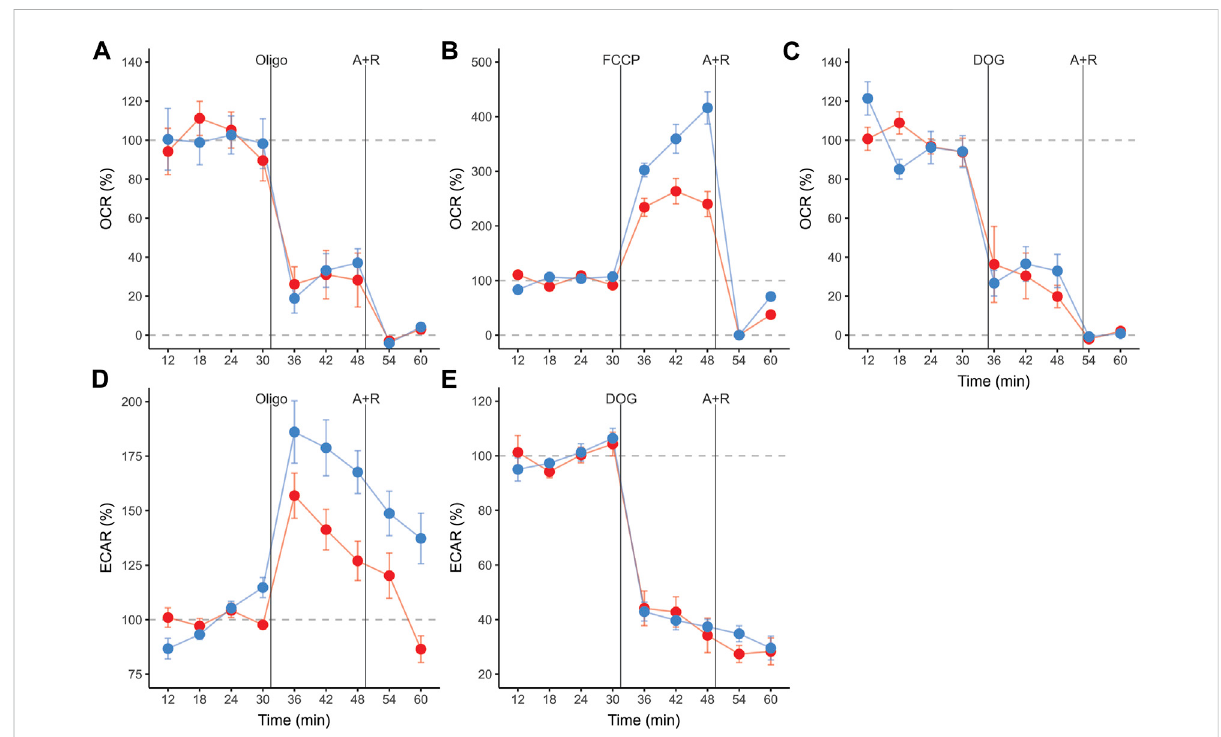
FIGURE 3 Real-time measurements of oxygen consumption rate (OCR) (A,B,C) , and extracellular acidi fi cation rate (ECAR) (D,E) in mouse sperm before and after treatment with metabolic modulators. Values are expressed as percentages relative to the basal state (100%), which was de fi ned as the mean of the four measurement cycles before any addition and is represented by the horizontal dashed line. Sperm were incubated for 1 h in non- capacitating (red symbols) and capacitating (blue symbols) conditions prior to extracellular fl ux analysis. Symbols and whiskers correspond to means±standarderror.Time=0wasde fi nedasthestartofthe fi rstmeasurementcycle;measurementcycles3to11arereported.Dashedgreylines indicate100%and0%levels.The fi rstverticallinemarkstheadditionofeither5 µMoligomycin,1 µMFCCP,or50 mM2DOG;thelinelabeled “ A+R ” marks the addition of 1 µM antimycin A+ 1 µM